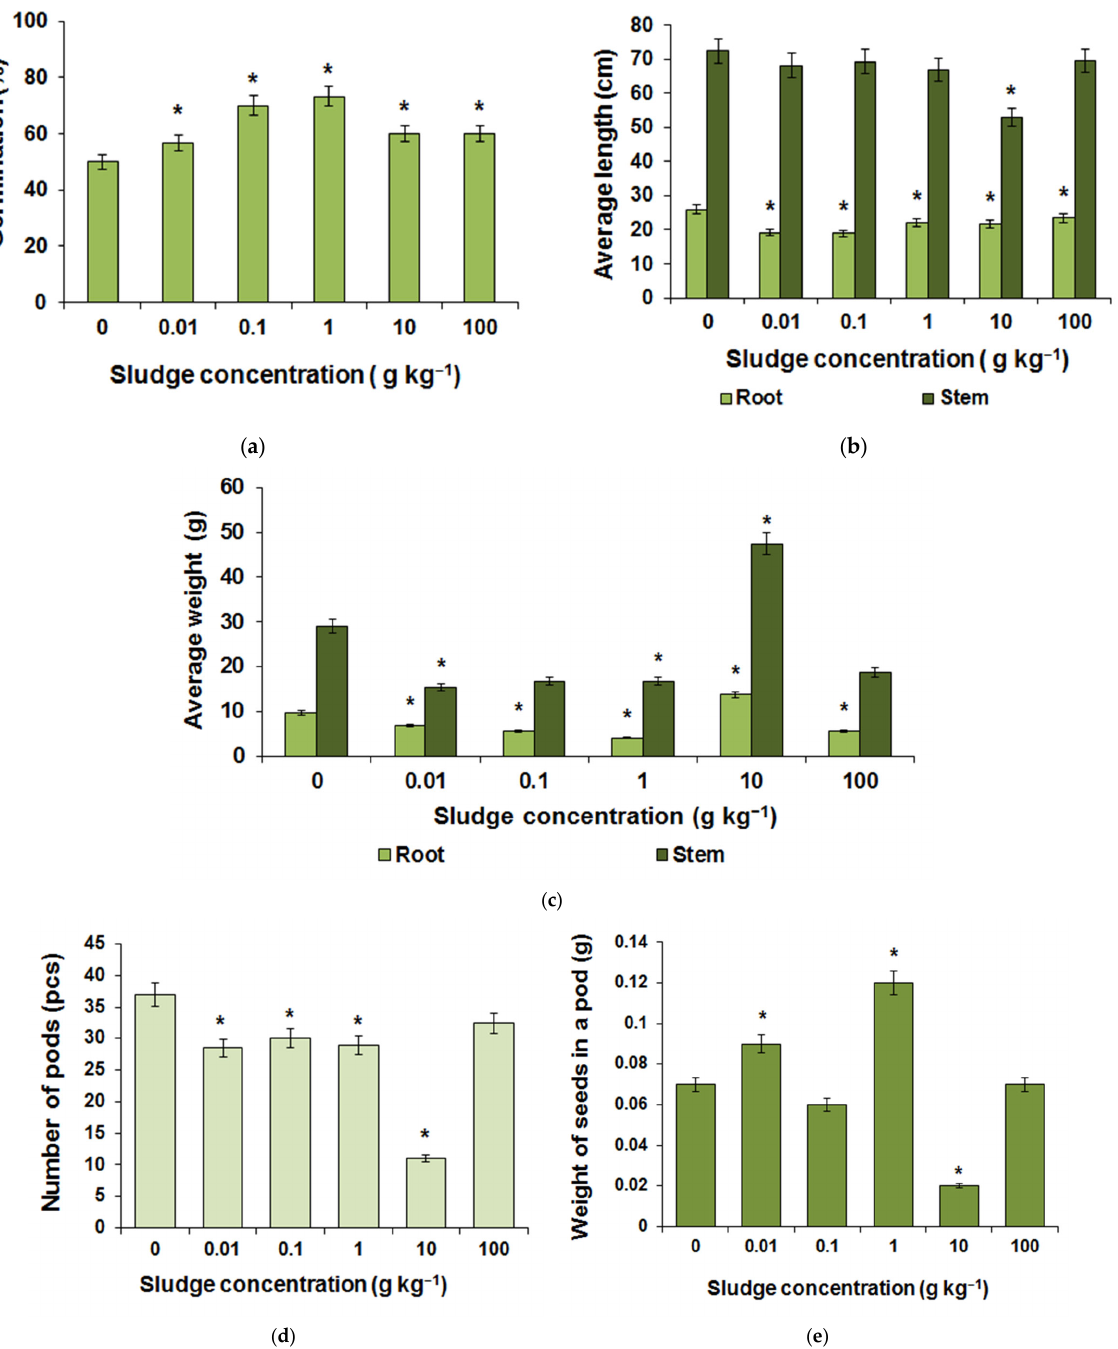
Figure 7. Influence of sludge on rapeseed in a greenhouse experiment: ( a ) Germination rates; ( b ) morphometric indicators; ( c ) biomass growth; ( d , e ) development of generative organs. n = 90. *—significant differences with the control.